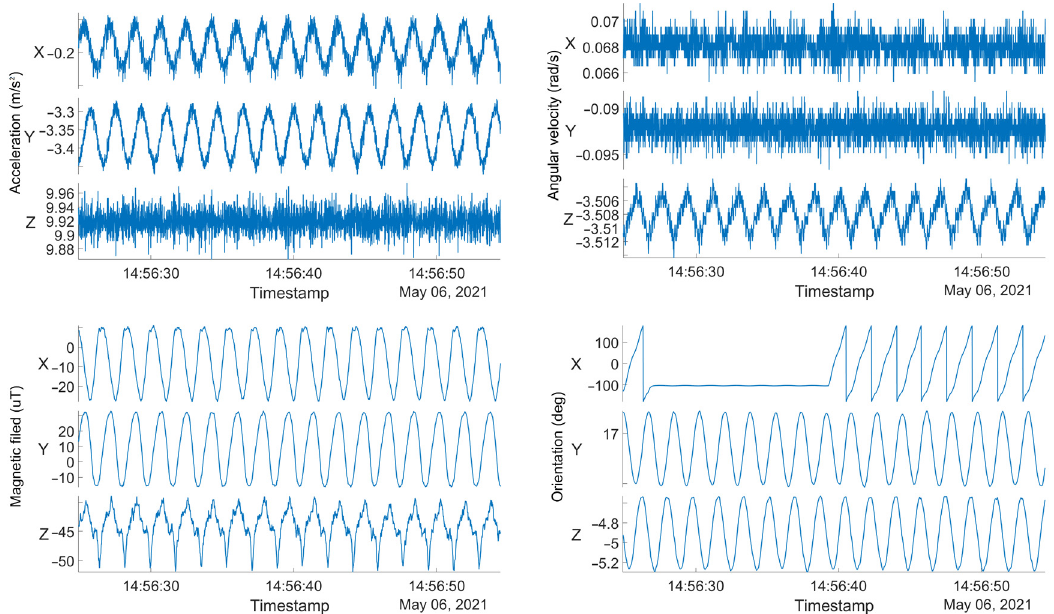
Figure 3. An example of the measured raw dataset from the IMU sensors on a smartphone. From left to right and from top to bottom: triaxial acceleration in m/s 2 , angular velocity in rad/s, magnetic field in µT, and orientation (yaw, pitch, and roll) in degrees.